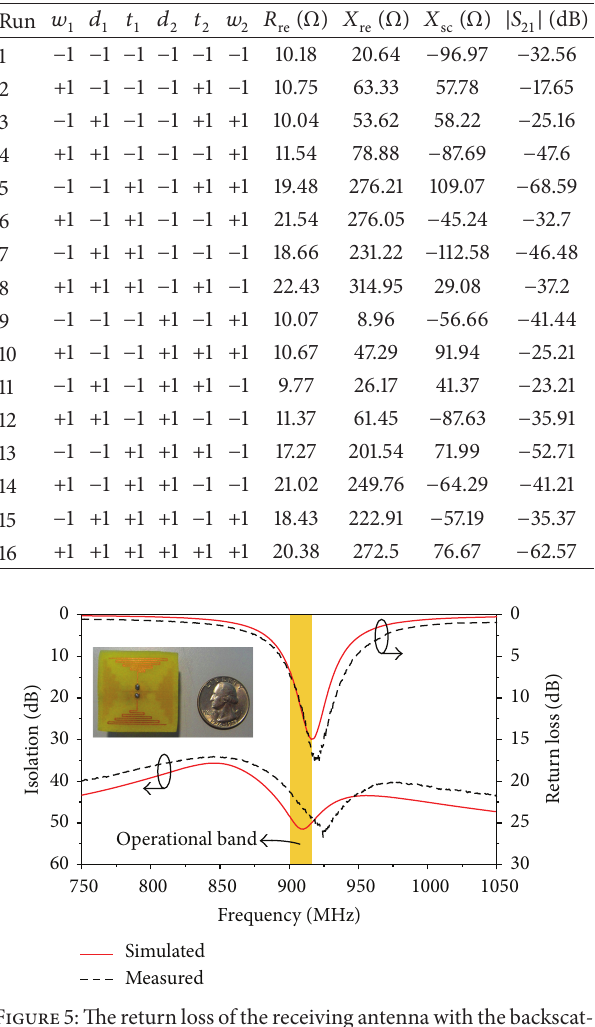
Figure 5: The return loss of the receiving antenna with the backscat- tering antenna being open-circuited and the isolation between the two antennas. Shown in the inset is the photograph of the fabricated